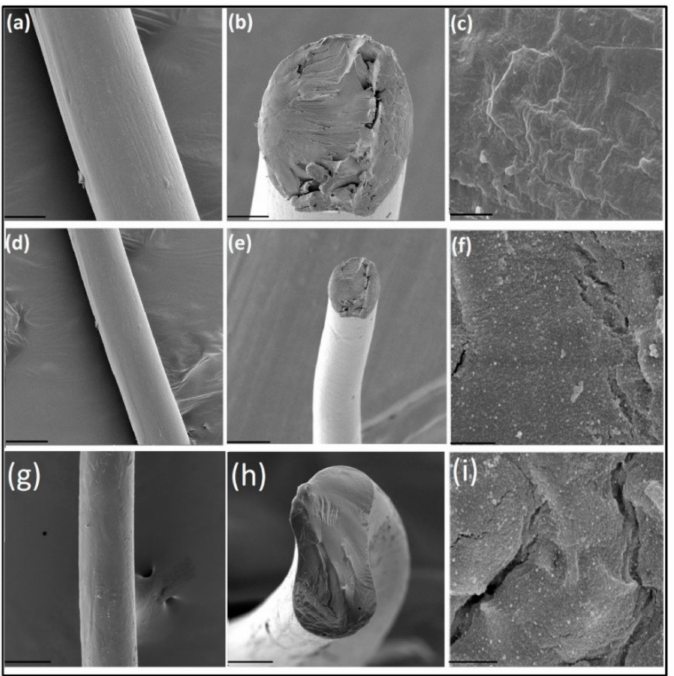
Figure 12. Scanning electron micrographs of plain HYH fibers ( a ); cross section of HYH fibers ( b ); HYH fibers at high magnification ( c ); a HYH/Ag-NPs-1 mg fiber ( d ); cross section of the HYH/Ag- NPs-1 mg fiber ( e ); the HYH/Ag-NPs-1 mg fiber at high magnification ( f ); a HYH/Ag-NPs-2 mg fiber ( g ); cross section of the HYH/Ag-NPs-2 mg fiber ( h ); the HYH/Ag-NPs-2 mg fiber at high magnification ( i ). Scale bars for ( a , d , g ), 100 µ m; ( b , e , h ), 50 µ m; and ( c , f , i ), 2 µ m. Reproduced